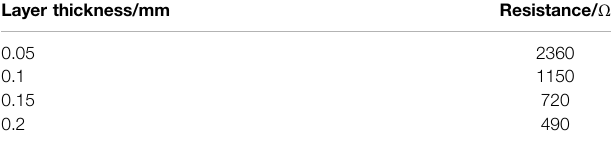
TABLE 2 | Resistance of different layer thicknesses.